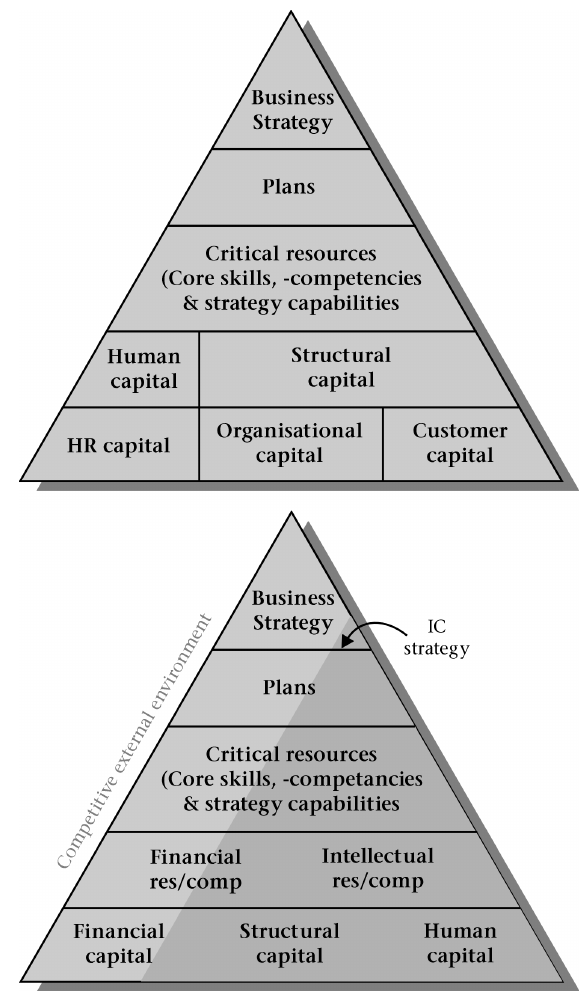
Figure 4:Comparison of IC Models